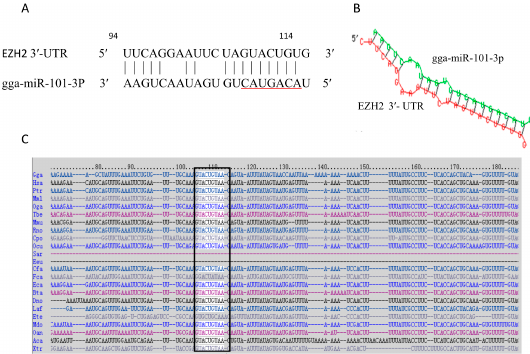
Figure 1. Prediction of the target gene of gga-miR-101-3p. ( A ) Sequence alignments of gga-miR-101-3p and the target site in the 3 ′ -UTR of EZH2. The seed sequence of gga-miR-101-3p is underlined, and the complementary nucleotides between gga-miR-101-3p and EZH2 3 ′ -UTR are indicated; ( B ) Secondary structure of the RNA duplex of gga-miR-101-3p and EZH2 3 ′ -UTR target site (Red: Target sequence; Green: gga-miR101-3p); ( C ) Sequence alignment of EZH 2 3 ′ -UTR from different species. The conserved target sequences are highlighted. Species abbreviations refer to the website link [56].